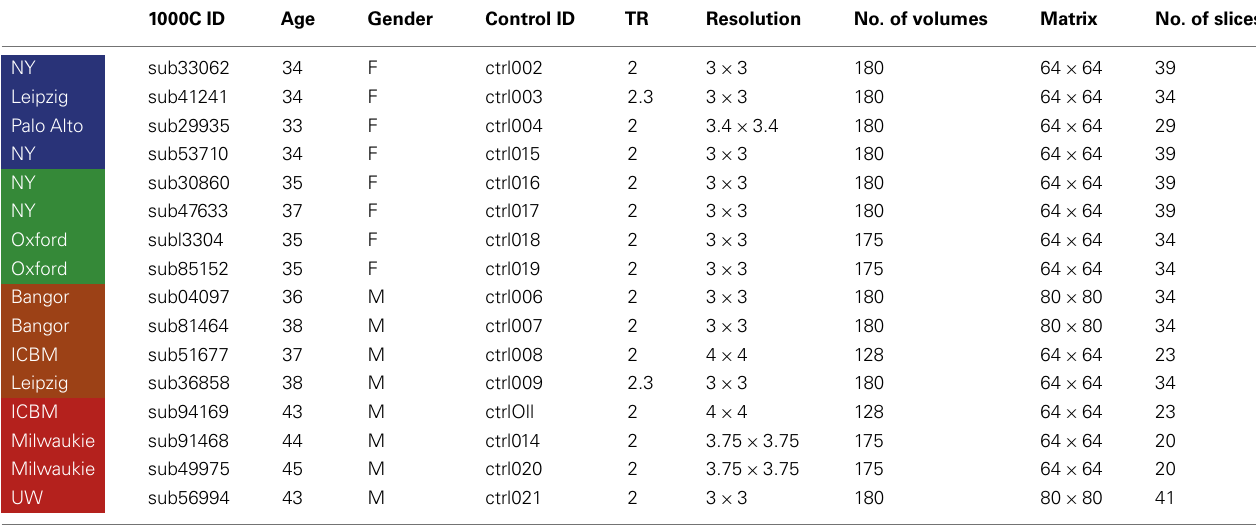
TableA1 | Control subject demographic information and scanning